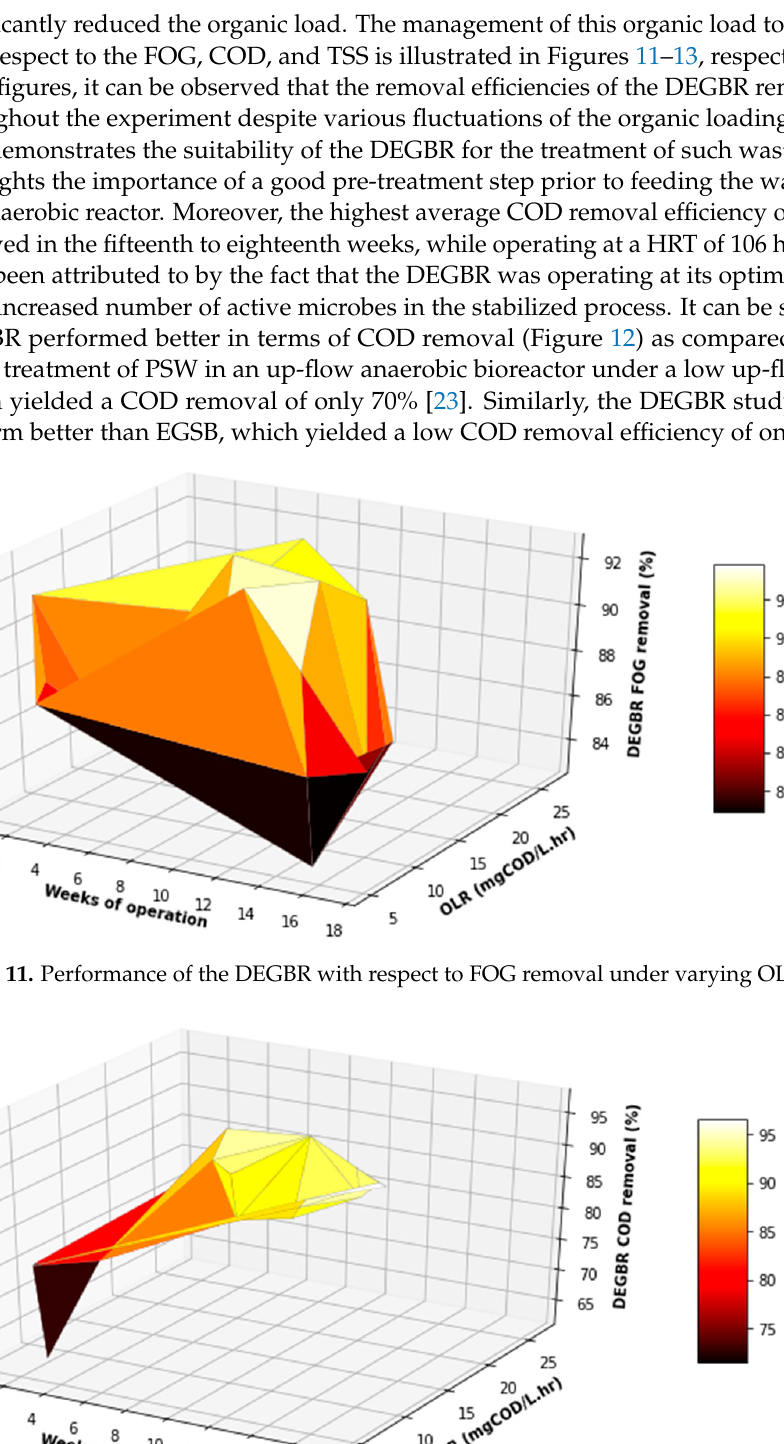
Figure 13. Performance of the DEGBR with respect to the TSS removal under varying OLRs. 3.2.1. The Effect of pH, Temperature and VFA/Alkalinity on the DEGBR Performance Organic matter degradation happens in the DEGBR and it involves the decomposi- tion of a large organic compounds into a simpler constituent for assimilation. The rate at which complex organic matter is degraded depends on the pH, temperature of the biore- actor, and molecular size of the pollutants including biomass activity [25]. However, there is no overall ideal operational pH, because all processes use consortia of micro-organisms,